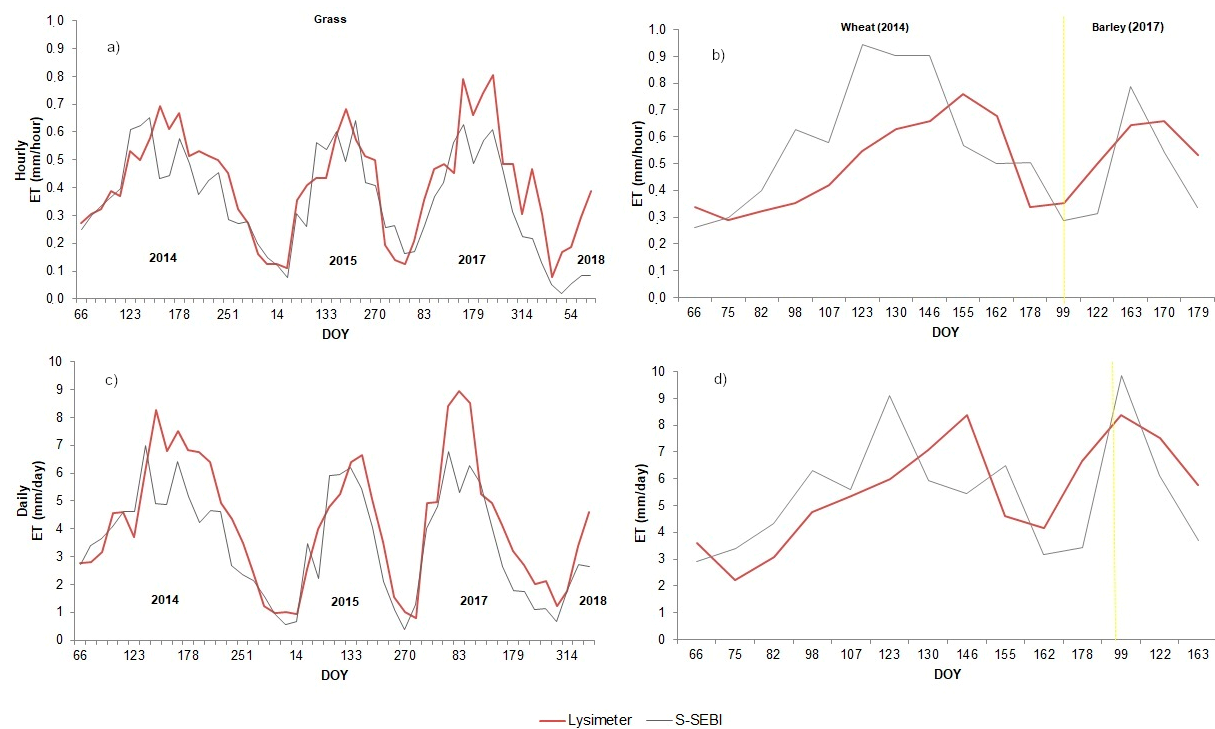
Figure 6. ( a ) Grass hourly evapotranspiration; ( b ) crops hourly evapotranspiration (mm/h) ET; ( c ) grass daily evapotranspiration; ( d ) crops daily evapotranspiration (mm/day). The yellow line indicates the date when the lysimeter begins to measure Barley ET instead of Wheat ET.